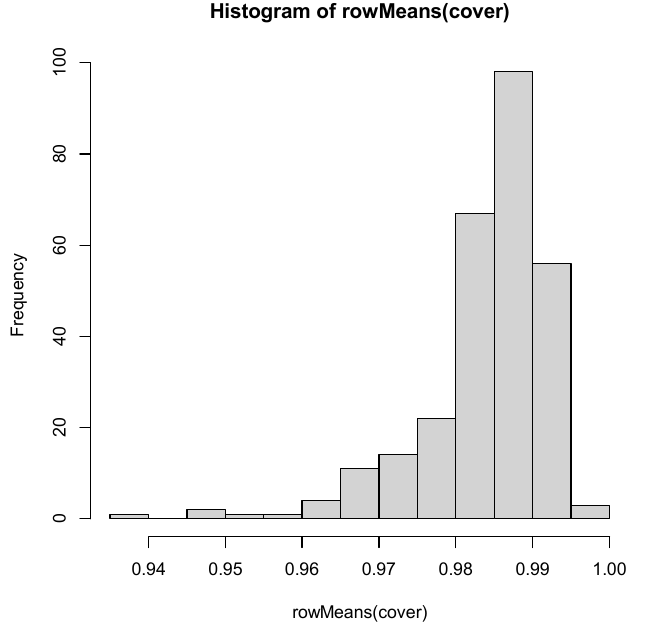
Figure A5. Histogram of row means of canopy cover.